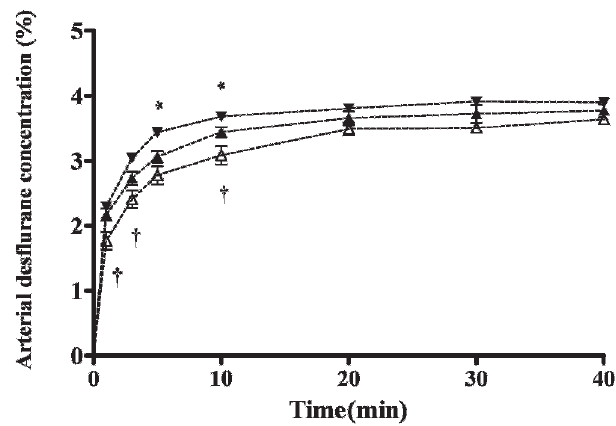
Figure 2 - Arterial desflurane concentration (Ades) time curves under three different ventilatory states, including hyperventila- tion (-- . --), normal ventilation (-- m --),and hypoventilation (-- g --) during 40 minutes of study.Data are presented as the mean ¡ standard deviation.Statistically significant differences are shown by * p , 0.05 for hyperventilation vs . normal ventilation, and { p , 0.05 for hypoventilation vs. normal ventilation.